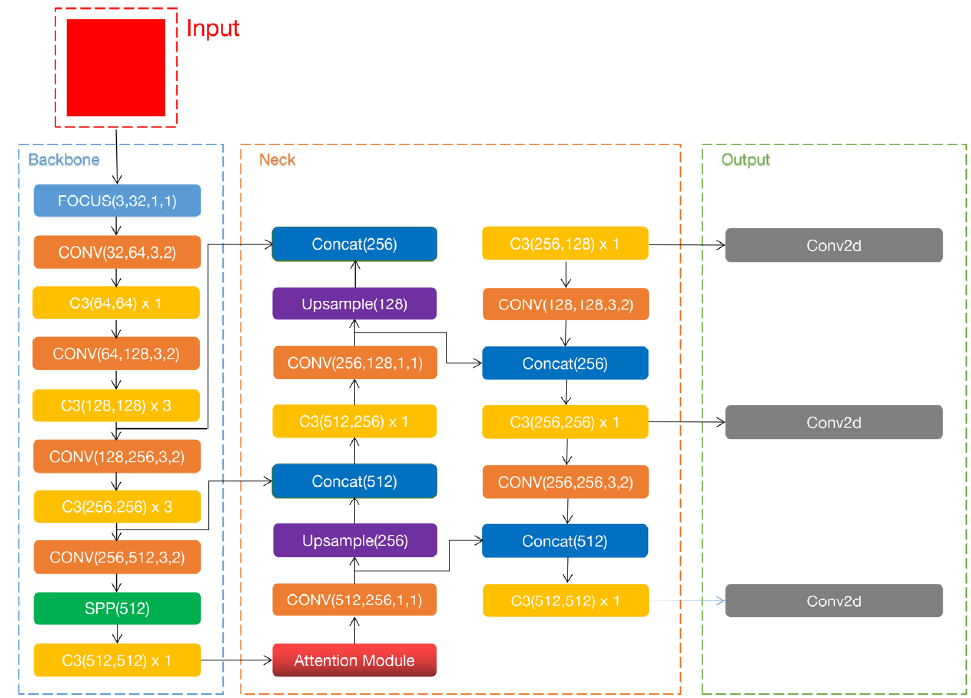
Figure 1. Improved structure of YOLOv5s network model. An attention module is added to the backbone part to capture the important feature information in the backbone and introduce the feature fusion